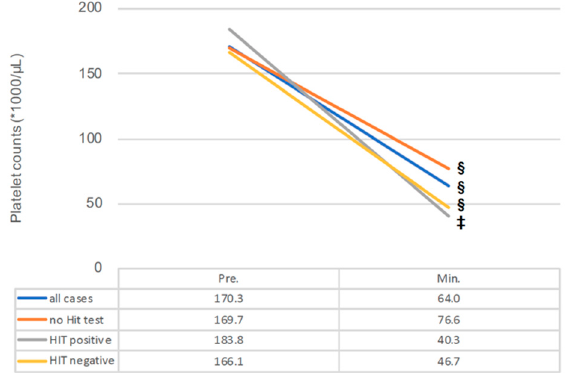
Figure 2. Changes in platelet counts under Impella 5+ support with or without clinically triggered HIT diagnostic. Min., minimum; HIT, heparin-induced thrombocytopenia; Impella 5+, Impella 5.0 or 5.5; Pre., preimplantation of Impella 5+; ‡, p < 0.005; §, p < 0.001. *,